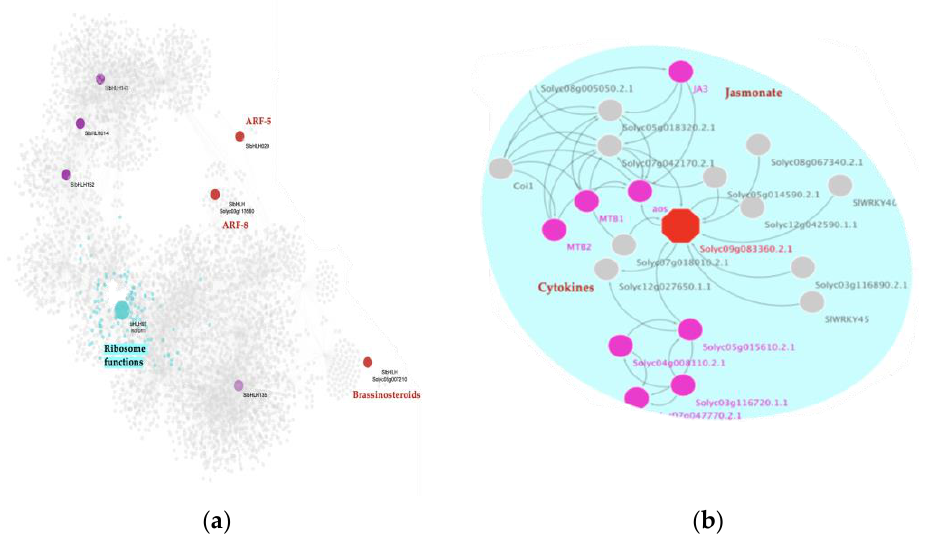
Figure 6. Microproteins predictive role in PSTVd severe infection: ( a ) Subnetwork depicting the presence of eight bHLH-TFs predicted as potential microproteins. Nodes in red represent those that are related to hormone-events at a protein-protein interaction level. Node in cyan represents the bHLH-TF encoding the bHLH92 isoform identified as an MTR and its corresponding regulon (small nodes in the same color). Functional enrichment of its regulon is highlighted in cyan. Nodes in purple represent the other predictive bHLH-miPs on the network; ( b ) Protein-protein interaction network of the bHLH92 isoform ( Solyc09g083360.2.1 ). The hexagon node represents this microprotein, while the fuchsia nodes indicate the connected interactors related to jasmonate signaling (MYC2/JA3 bHLH transcription factor), while the others are linked to cytokines signaling events.